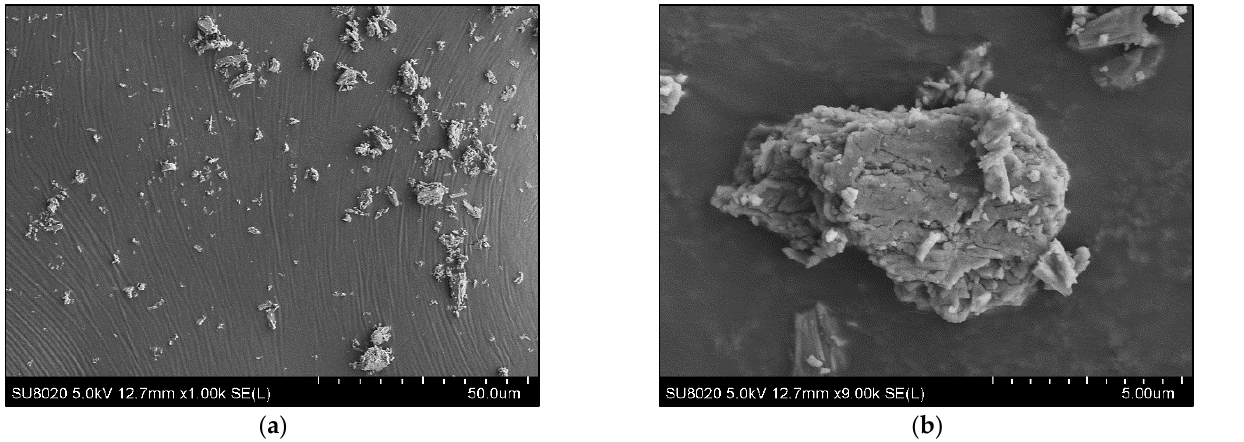
Figure 2. ( a,b ) SEM images (SE mode) at ( a ) low and ( b ) high magnification of AII